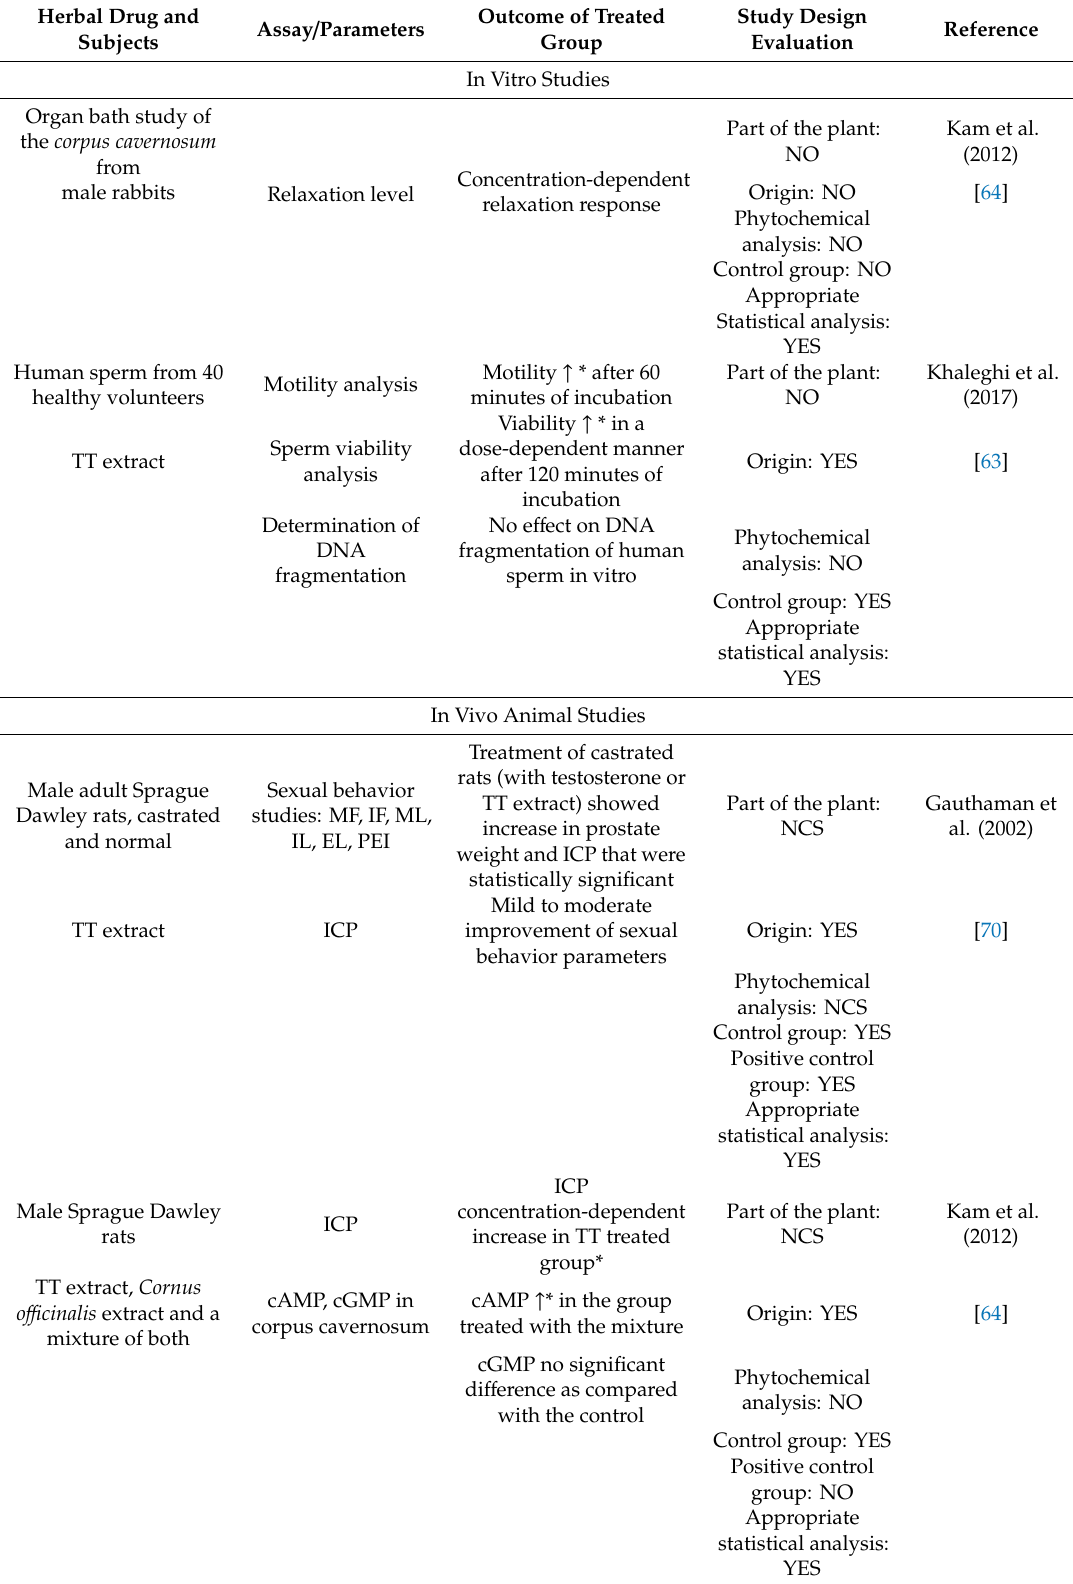
Table 3. In vitro and in vivo studies regarding the e ffi cacy of TT extracts in sexual disorders and their design